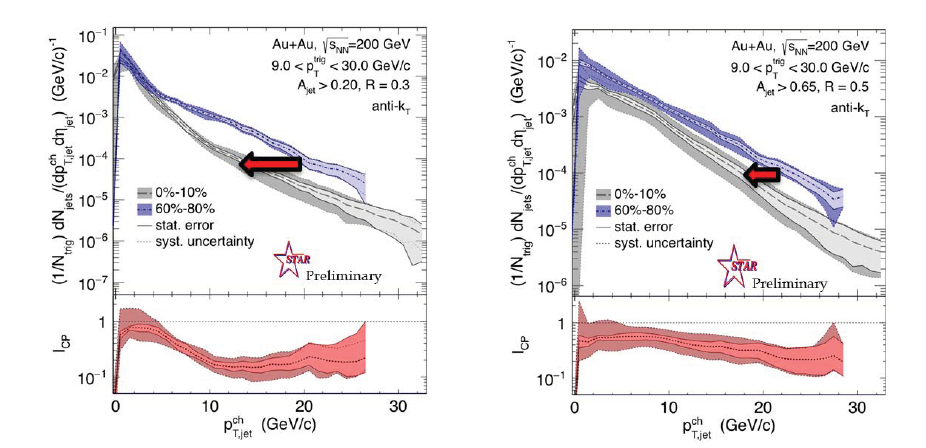
Figure 3. (Color online) Hadron-jet correlations [10]: recoil jet p T spectra in peripheral and central Au + Au collisions for R = 0 . 3 and R = 0 . 5 (upper) and I AA , ratio of jet spectra in central to peripheral collisions